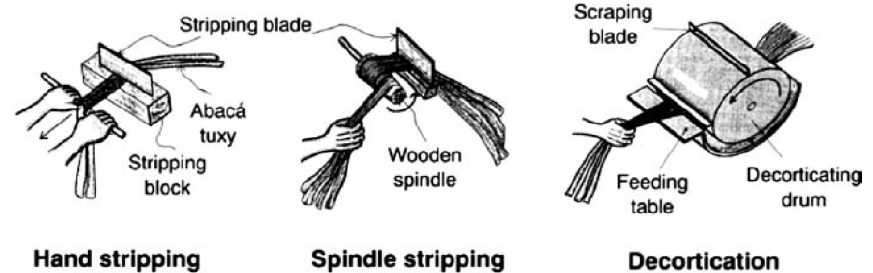
Figure 2. Extraction systems for lignocellulosic fibres from musaceae pseudostems. Figure repro- duced with permission from reference [54]; copyright 2010 John Wiley & Sons